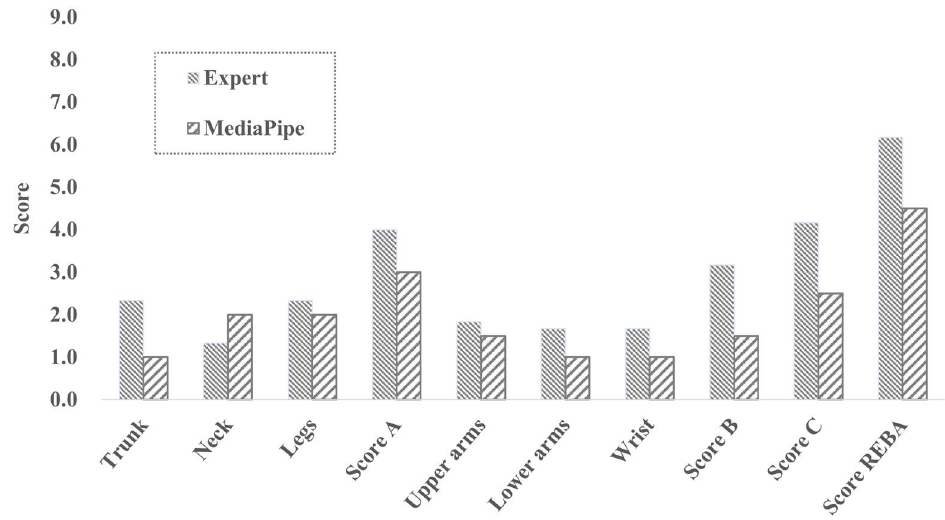
Figure 35. Comparison of cutter working posture scores.